Question: Summarize what this figure shows in one sentence.
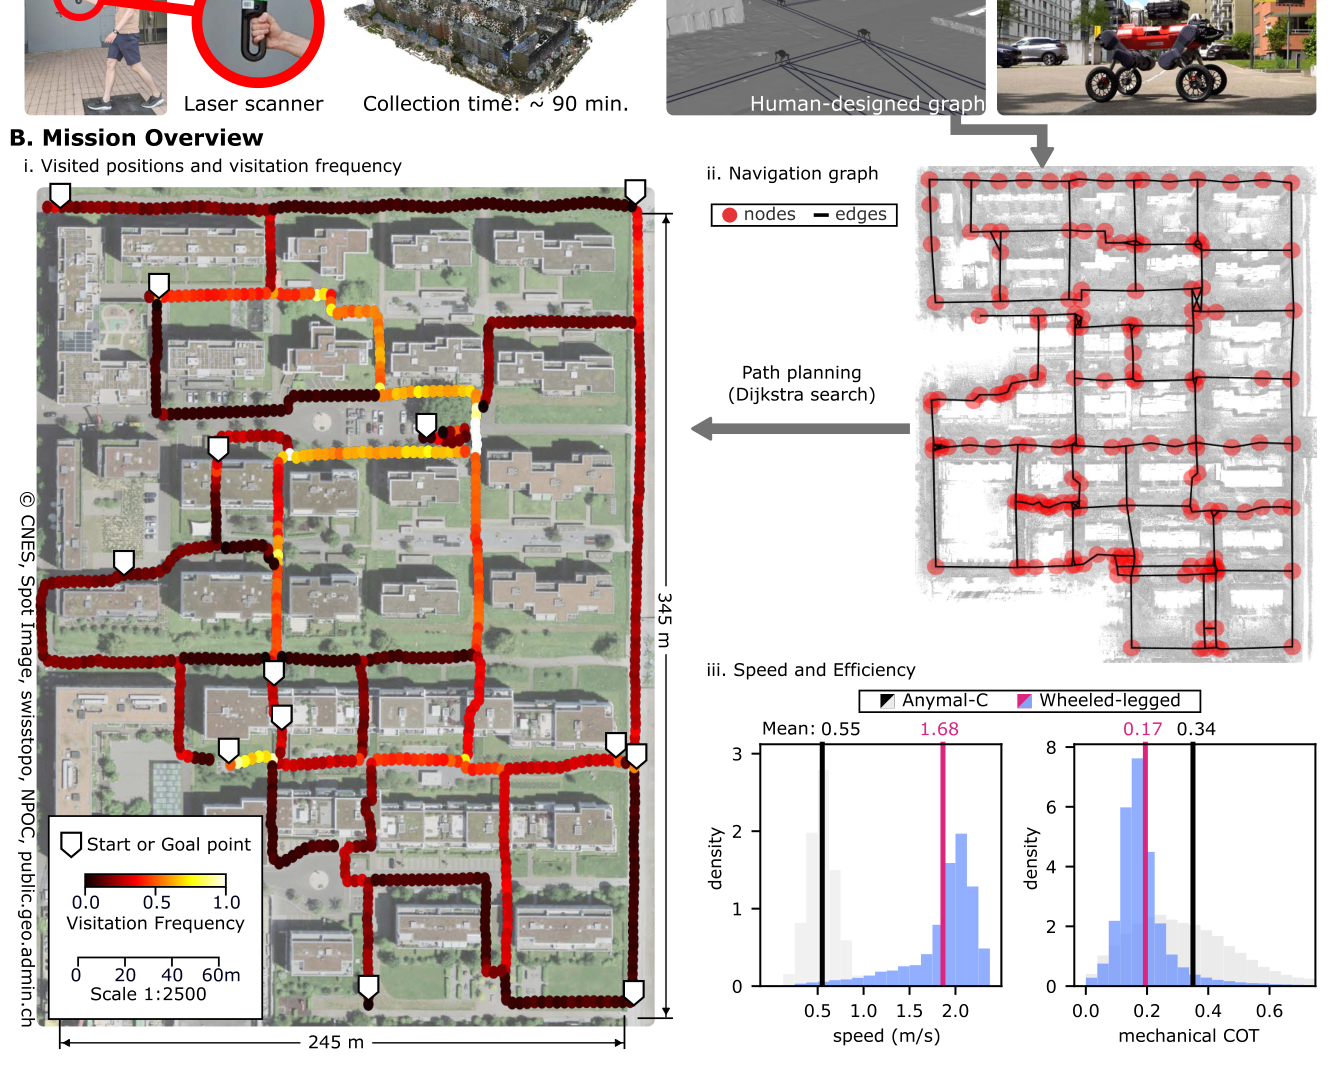
Answer: Large scale autonomous navigation experiment at Glattpark, Zurich. (A) Our city navigation workflow begins with offline prepara- tion, involving scanning the test area using a handheld laser scanner and constructing a navigation graph. (B) The robot autonomously navigated the urban environment to reach 13 predetermined goal points, selected in an arbitrary order. (B-i, ii) Path planning within the city was facilitated by the pre-generated navigation graph. (B-iii) Moving speed and mechanical cost of transport compared to a normal legged robot (ANYmal-C).